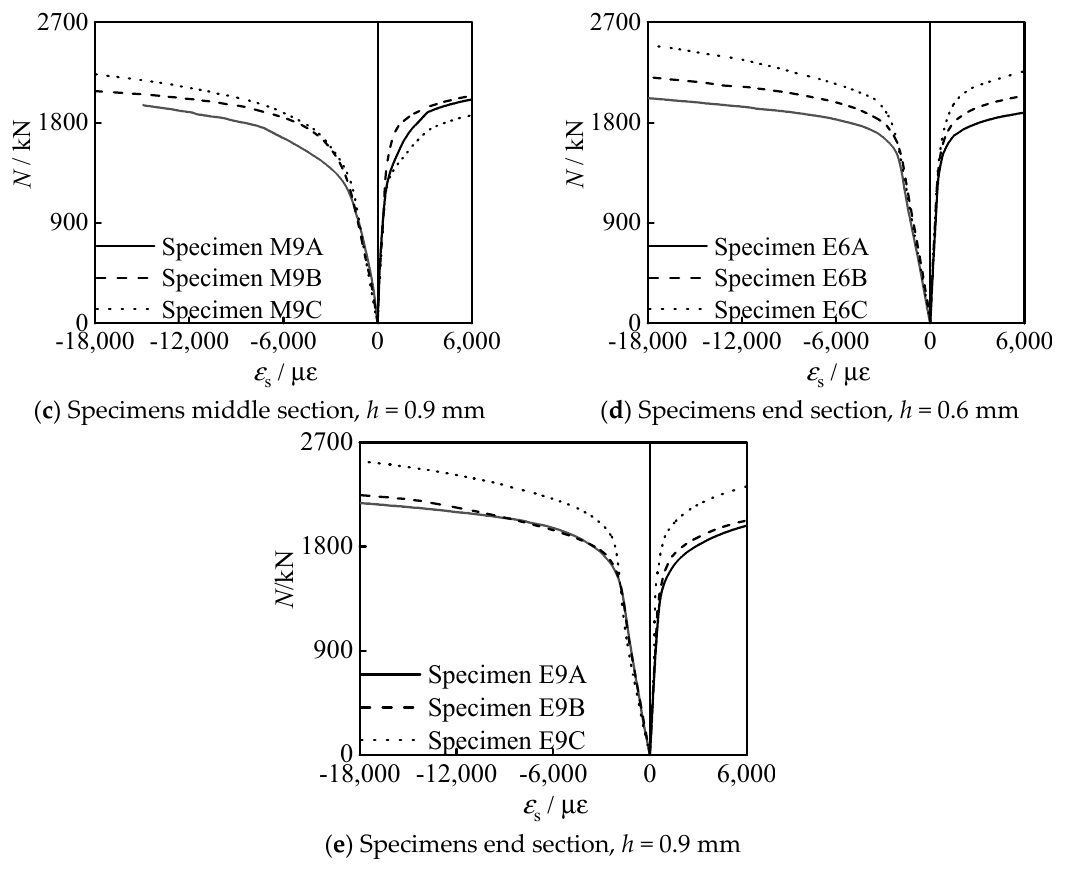
Figure 11. N- ε s curves of all specimens.